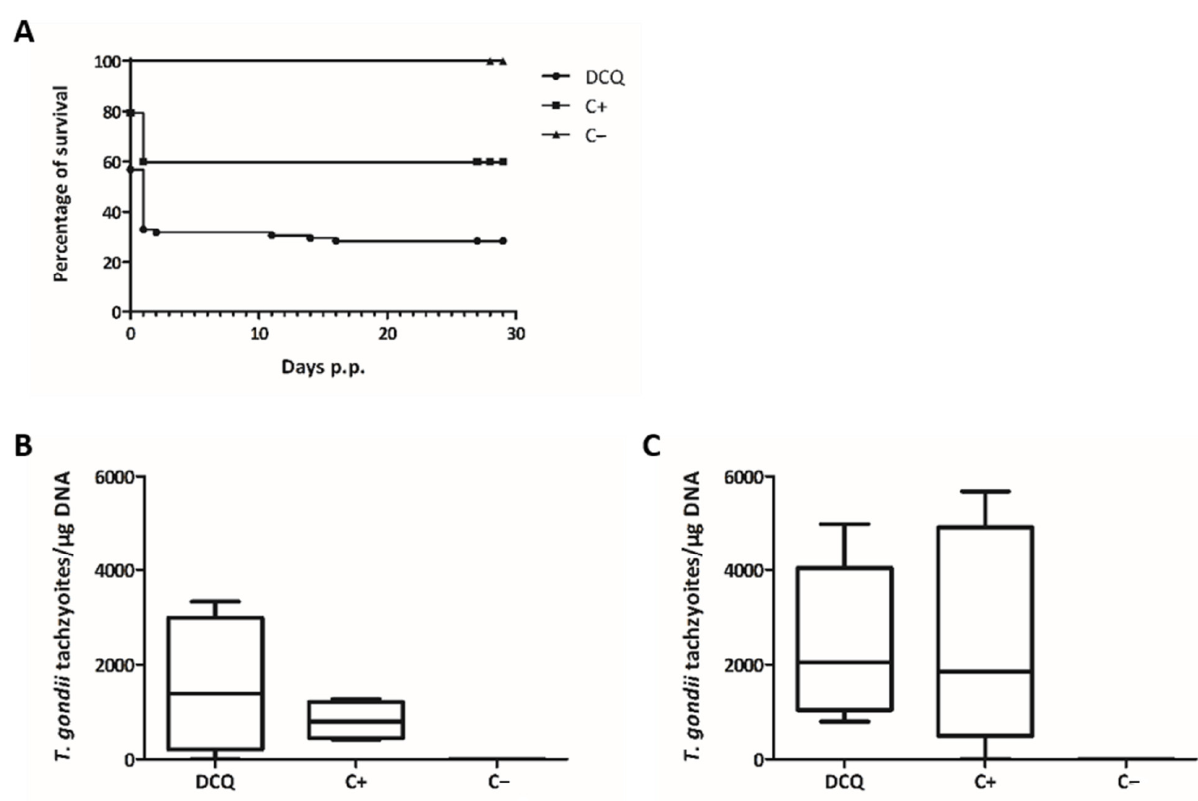
Figure 2. DCQ treatment in the pregnant toxoplasmosis mouse model. Survival curves of pups ( A ) and cerebral parasite burden of non-pregnant mice ( B ) and dams ( C ). Survival rates were plotted in Kaplan–Meier graphs at each time point and curves were compared by the Log-rank (Mantel–Cox) test. Differences between the three curves were highly significant ( p < 0.0001). CD1 mice were infected with 50 TgShSp1 oocysts and treated with 10 mg/kg DCQ, while C+ was infected and treated only with corn oil. C − was not infected and treated with corn oil alone. Four weeks p.p. all mice were euthanized, brains were aseptically collected, and cerebral parasite burden was quantified by real-time PCR. The values are depicted as box plots and parasite burden between groups were compared by the Kruskal-Wallis test, followed by the Mann–Whitney U test. No statistically significant differences in the cerebral parasite burden were observed between DCQ-treated mice compared to the C+ group (neither in non-pregnant mice nor in dams).